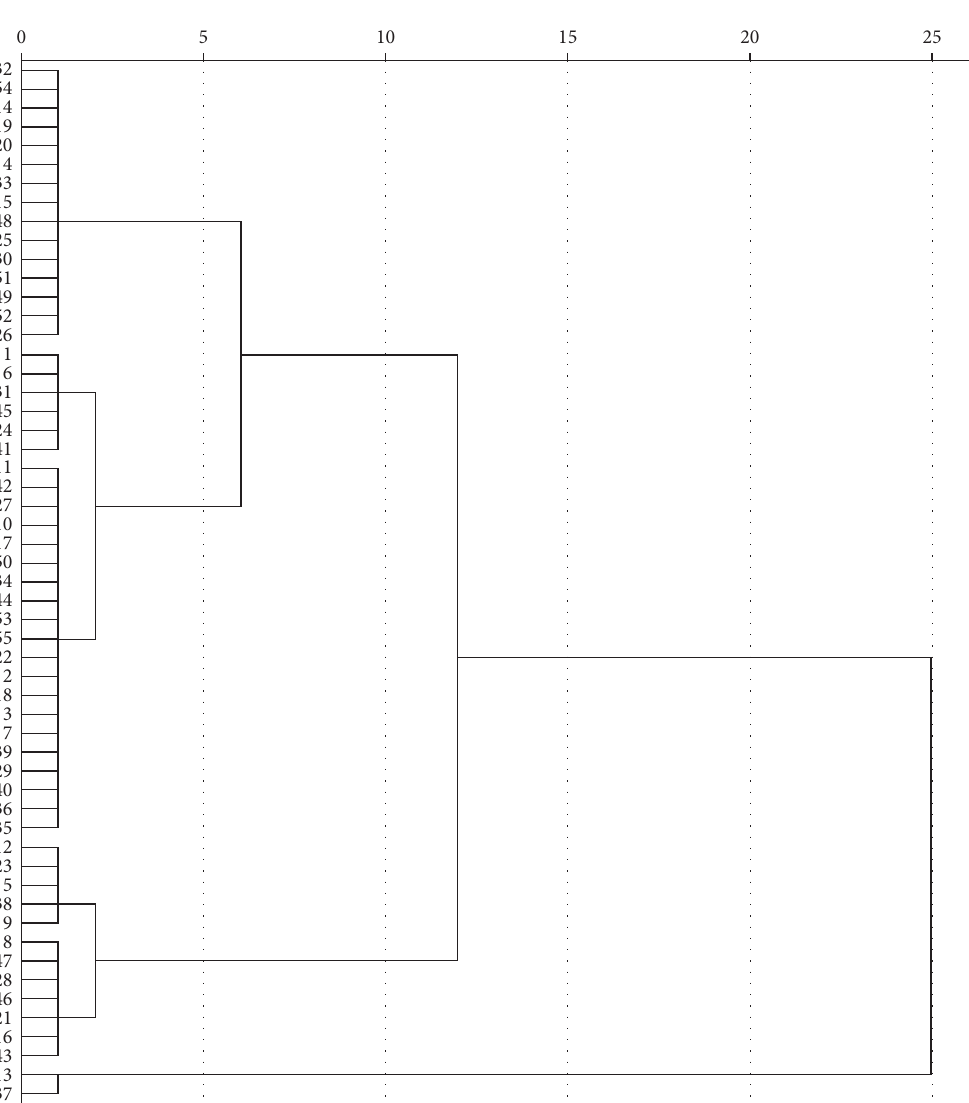
Figure 6: The cluster analysis tree of 55 batches of commercial SR (the indicator is the ratio of the total content of three chromone aglycones to the total content of six chromone